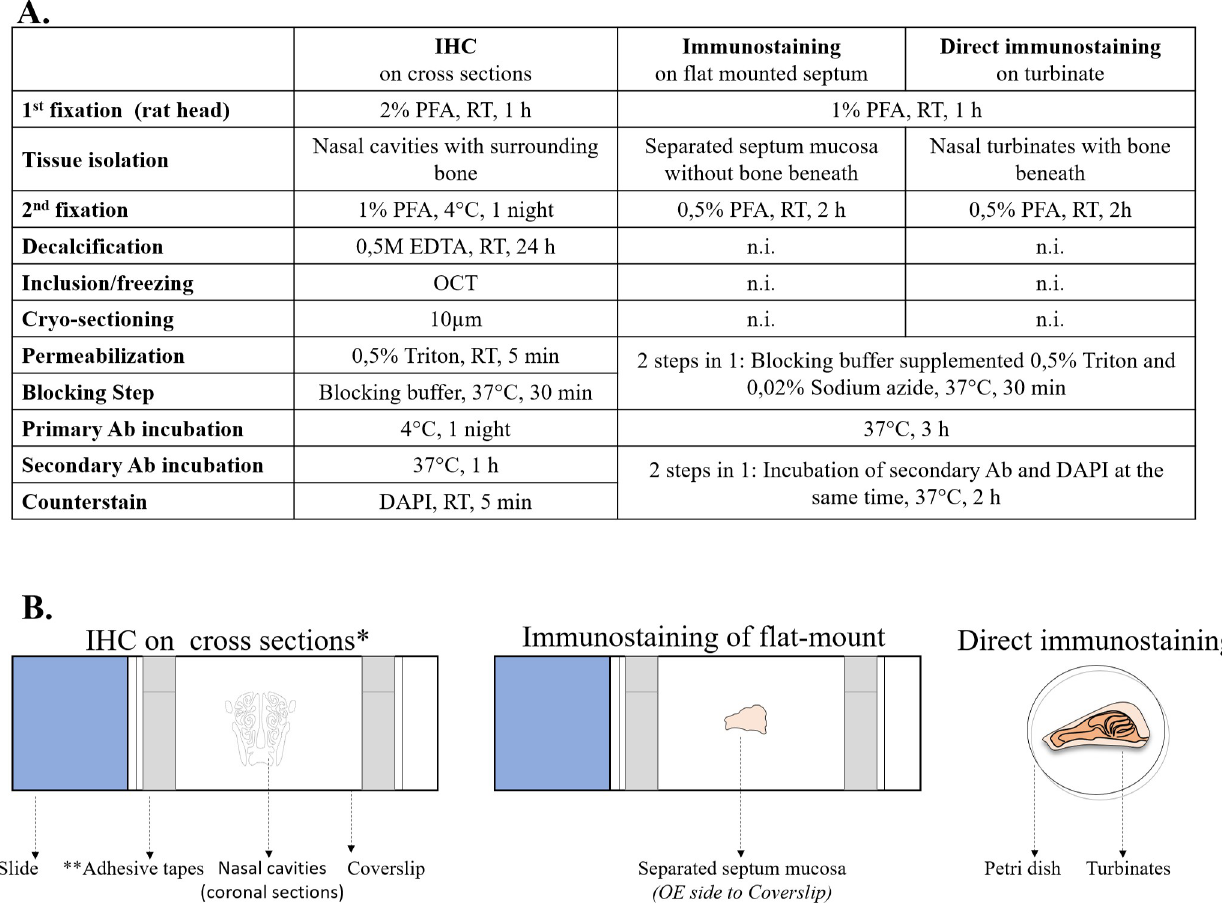
Fig 1. Summary of the 3 immunostaining techniques. A. Table clarifying the workflow. B. Schematic presentation of the tissue preparation for observation. Ab: antibody, DAPI: 4 0 ,6-diamidino-2-phenylindole, h: hour(s), IHC: immunohistochemistry, n.i.: not involved, OE: olfactory epithelium, OCT: Optimal cutting temperature compound, RT: Room temperature. � "Cross-section" here is a general term for the IHC technique and does not indicate the orientation of the tissue. The orientation of the nasal cavities was “coronal’ in this study. �� The purpose of adhesive tape was to prevent the coverslip from sliding on the microscope slide, which could damage the sample in